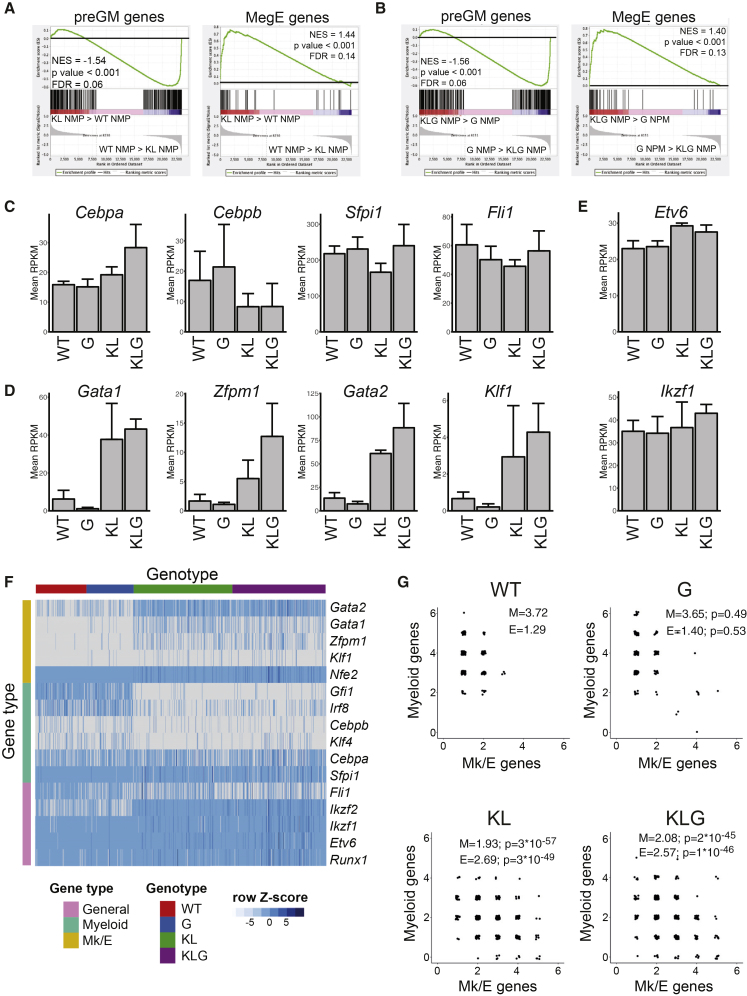
Biallelic Cebpa Mutations Install Ectopic Erythroid Lineage Programming in NMPs(A) GSEA of KL NMPs versus WT NMPs using pre-granulocyte-macrophage progenitor (preGM) (left panel) and MegE gene sets (right panel). NES, p value and FDR are indicated. n = 3 per genotype.(B) GSEA of KLG NMPs versus G NMPs using preGM (left panel) and MegE gene sets (right panel). n = 3 per genotype.(C) Histogram showing expression levels of selected myeloid TF-encoding genes measured by RNA sequencing in NMPs of the indicated genotypes. Values are mean RPKM ± SD, n = 3 per genotype.(D) Histogram showing expression levels of selected erythroid TF-encoding genes, as in (C).(E) Histogram showing expression levels of selected general hematopoietic TF-encoding genes, as in (C).(F) Multiplex qRT-PCR of myeloid and megakaryocytic/erythroid (Mk/E) TF genes on single NMPs. WT, n = 192; G, n = 192; KL, n = 384; KLG, n = 384. The heatmap shows 2–ΔCt values normalized to Hprt and centered on the mean value for each gene.(G) Scatterplot depicting the number of myeloid and Mk/E TF genes from (F) co-expressed in single WT, G, KL, and KLG NMPs. Each dot represents a single cell. The average number of myeloid (M) and Mk/E genes expressed is shown, as are the p values (Wilcox test) against the WT distribution for each gene set.See also Table S4.